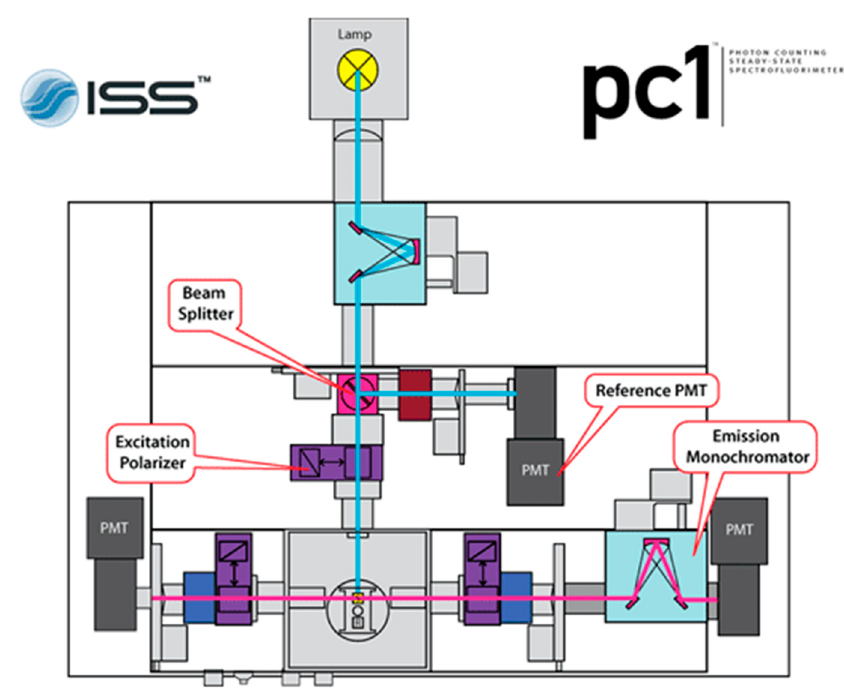
Figure 3. ISS PC1 instrument setup for polarization of incident light and detection of parallel and perpendicular polarized light after passing through the sample cuvette. This figure is from reference [21]. Here, once the sample is excited by polarized light, only the right instrument path is utilized, with the right photon multiplier tube collecting both parallel and perpendicular emissions in turn through software-controlled emission polarizer orientation adjustments (bottom right purple rectangle).